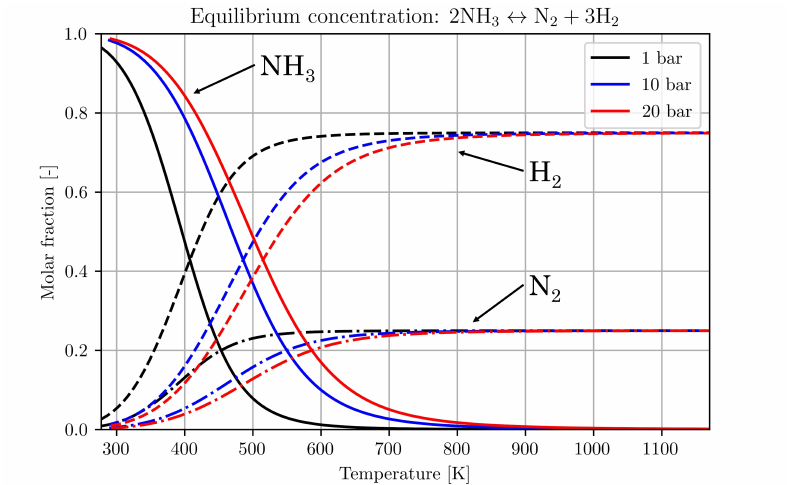
Figure 11. The equilibrium molar fractions of ammonia and its constituents as a function of tempera- ture. Produced using the Stagni et al. [21] combustion